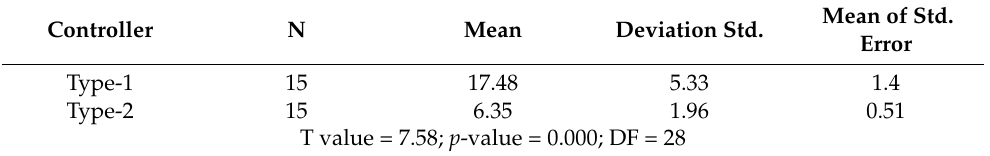
Table 6. Results for Student’s t -test using RMSE error in type-1 and type-2 fuzzy controllers. Controller N Mean Deviation Std. Type-1 15 17.48 5.33 1.4 Type-2 15 6.35 1.96 0.51